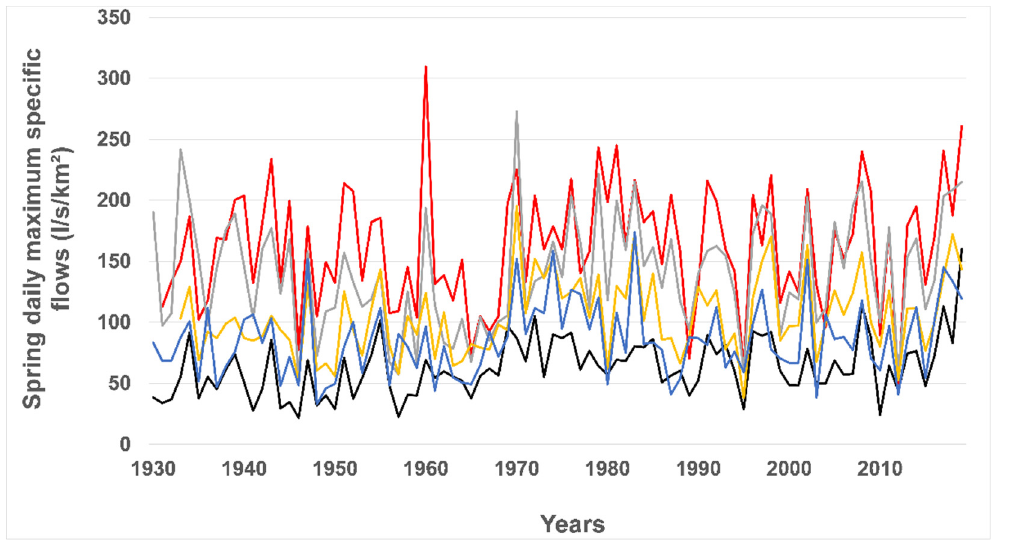
Figure 6. Interannual variability of spring daily maximum specific flows (l/s/km²) in the Southwest- ern hydroclimatic region from 1930 to 2019. Petite Nation River: black curve; Du Nord River: Red curve; L’Assomption River: grey curve; Matawin River: orange curve; Vermillon River: blue curve.